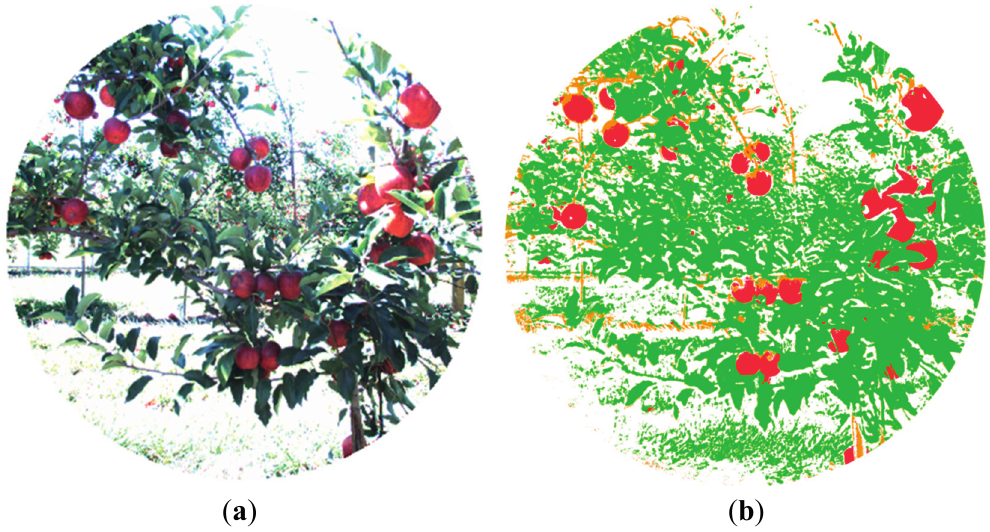
Figure 5. Apple orchard. ( a ) RGB image; ( b ) Classification map.